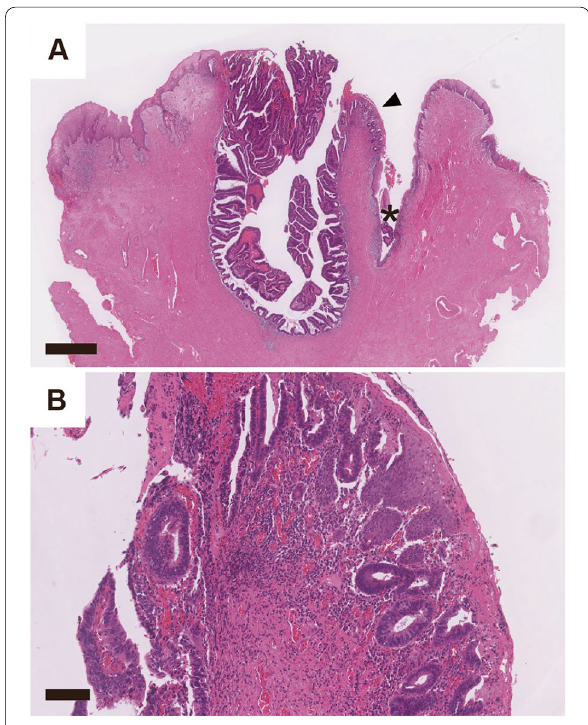
Fig. 2 Pathological findings of hematoxylin–eosin staining. A Hematoxylin–eosin staining. A magnified view of the arrowhead is shown in ( B ). The asterisk indicates contamination. Magnification: 12.5 , scale bar: 1000 µm. B Magnified view of the arrowhead in ( A ). × Magnification: 100 , scale bar: 100 ×